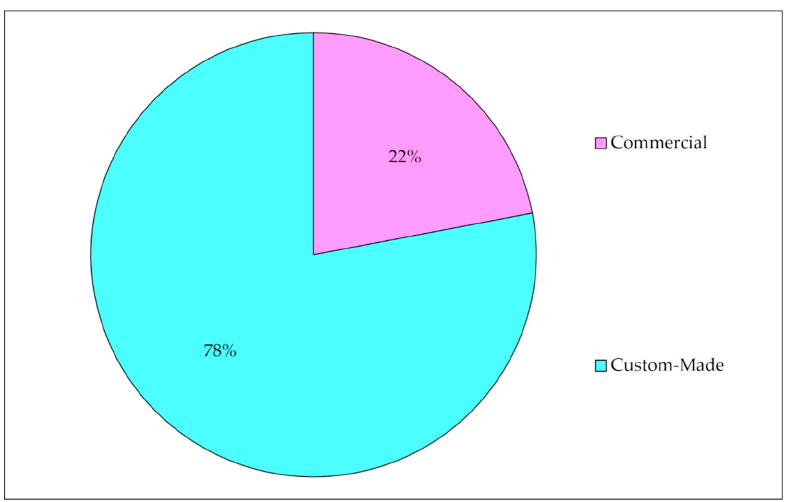
Figure 2. The pie chart shows the percentages of studies using commercial (22%) and custum-made (78%) simulators.